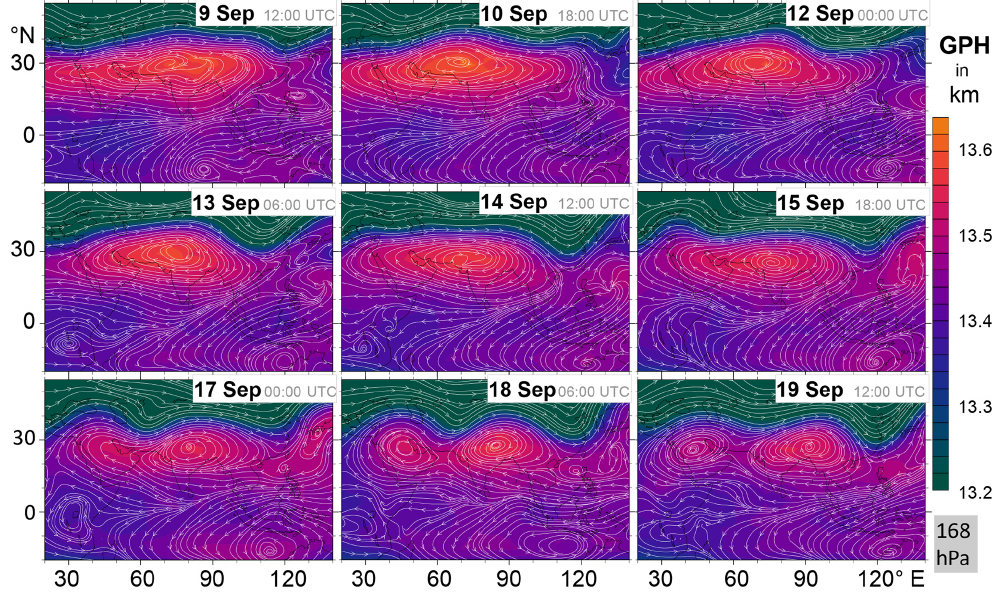
Figure 3. Streamlines and geopotential height (GPH) at the 168hPa pressure level as simulated by EMAC for selected output time steps in September 2012.